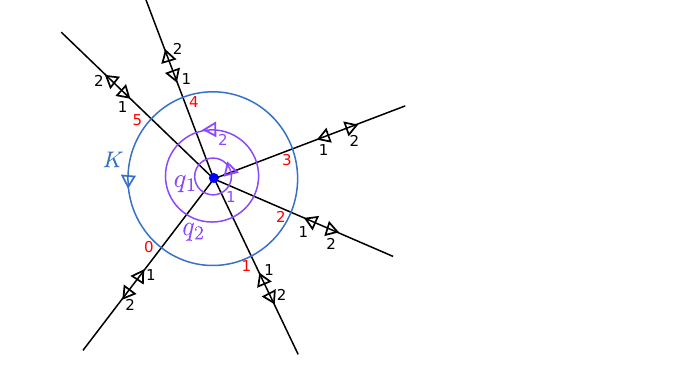
Figure 38 . An unknot K whose standard projection is a small loop around a puncture (denoted as a blue dot) on C . For simplicity, in this and following examples, we do not draw the leaf space projection. Instead, we specify x 3 -coordinates (in red) at points where the unknot meets a critical leaf. Between these points the x 3 -coordinate varies as simply as possible: this means it varies monotonically, except for critical points which we place immediately before crossing a critical